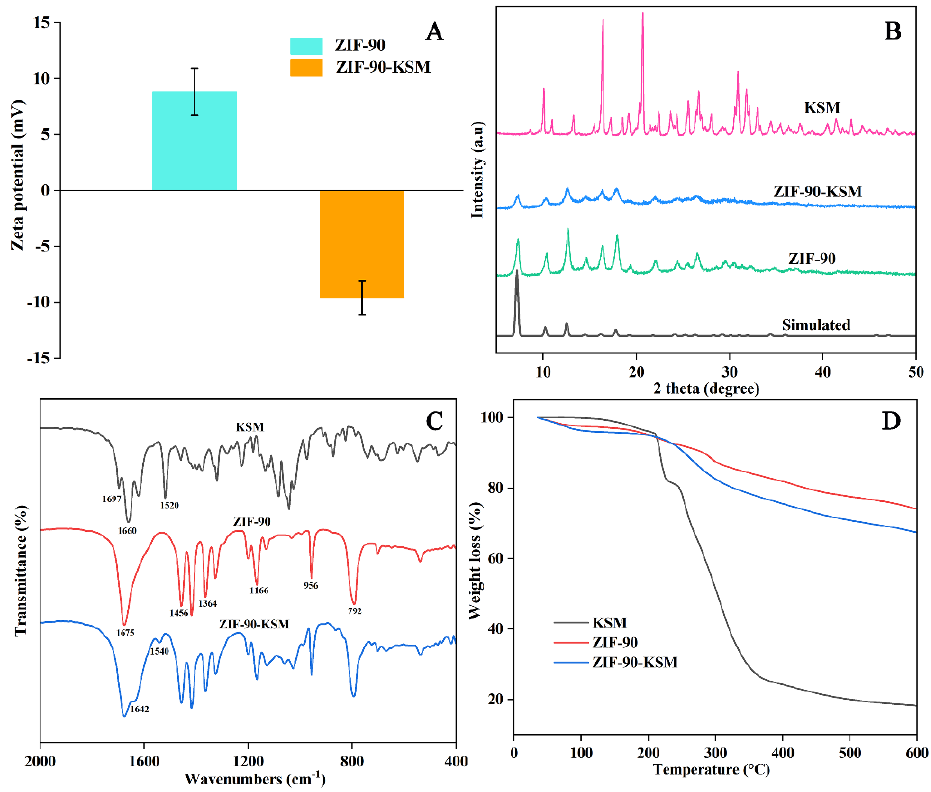
Figure 3. Zeta potential of ZIF-90 and ZIF-90-KSM ( A ), XRD patterns of KSM, ZIF-90 and ZIF-90- KSM ( B ), FTIR spectra of KSM, ZIF-90 and ZIF-90-KSM ( C ), and TGA curves of KSM, ZIF-90 and ZIF-90-KSM ( D ).